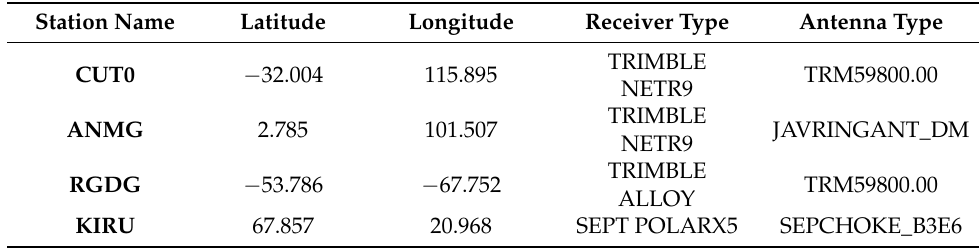
Table 3. The conditions of different collected stations.